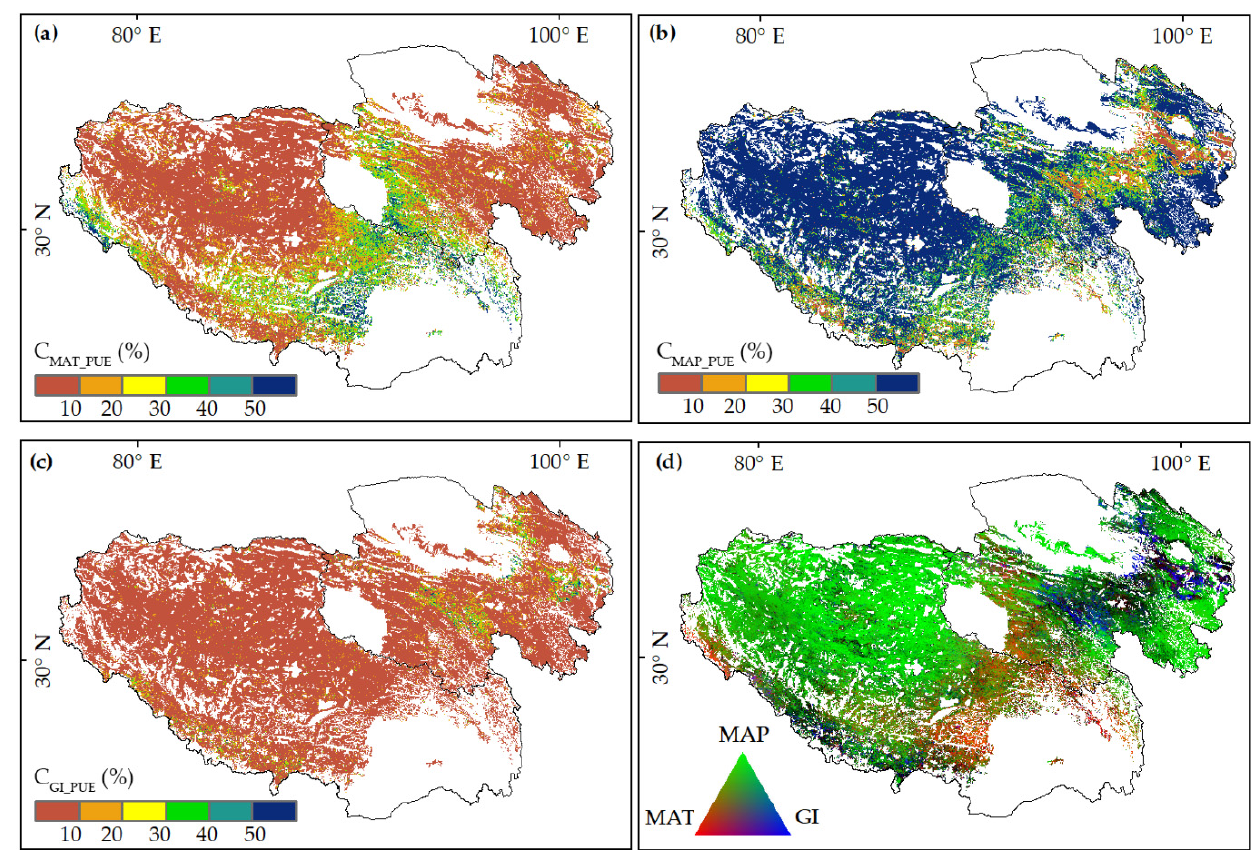
Figure 7. Relative contributions of ( a ) MAT, ( b ) MAP, and ( c ) GI to the PUE interannual variation. ( d ) The spatial pattern of the dominant variables, which was displayed by RGB composite (MAT: red; MAP: green; and GI: blue).